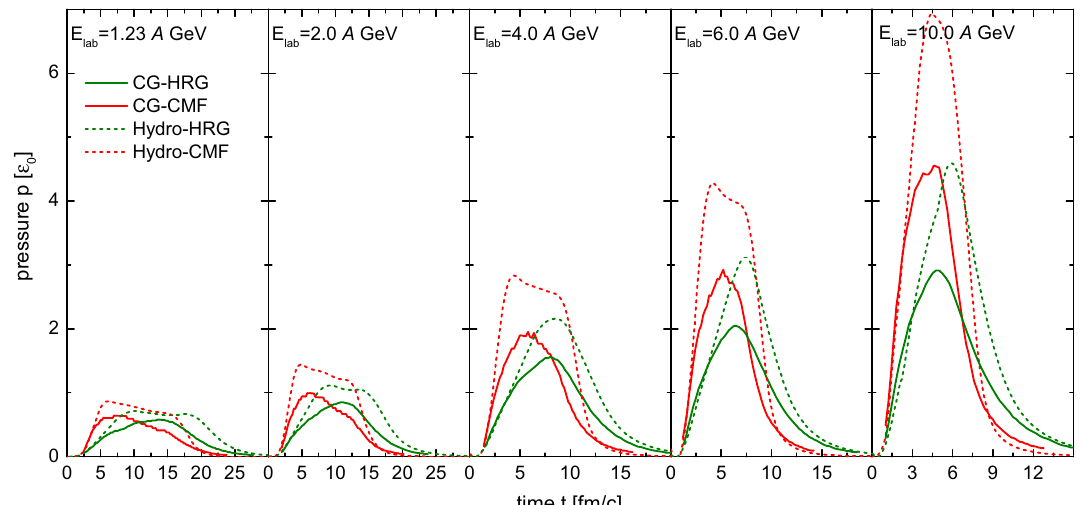
Fig. 6 Time evolution of the pressure in units of the ground-state energy density in the central cell of the reaction for central Au+Au reactions at E lab = 1 . 23 , 2 . 0 , 4 . 0 , 6 . 0 , 10 . 0 A GeV (from left to right). Thefulllinesshowtheresultsofcoarsegrained UrQMD simulationsand thedashedlineshowstheresultsforone-fluid(3+1)dimensionalhydro-